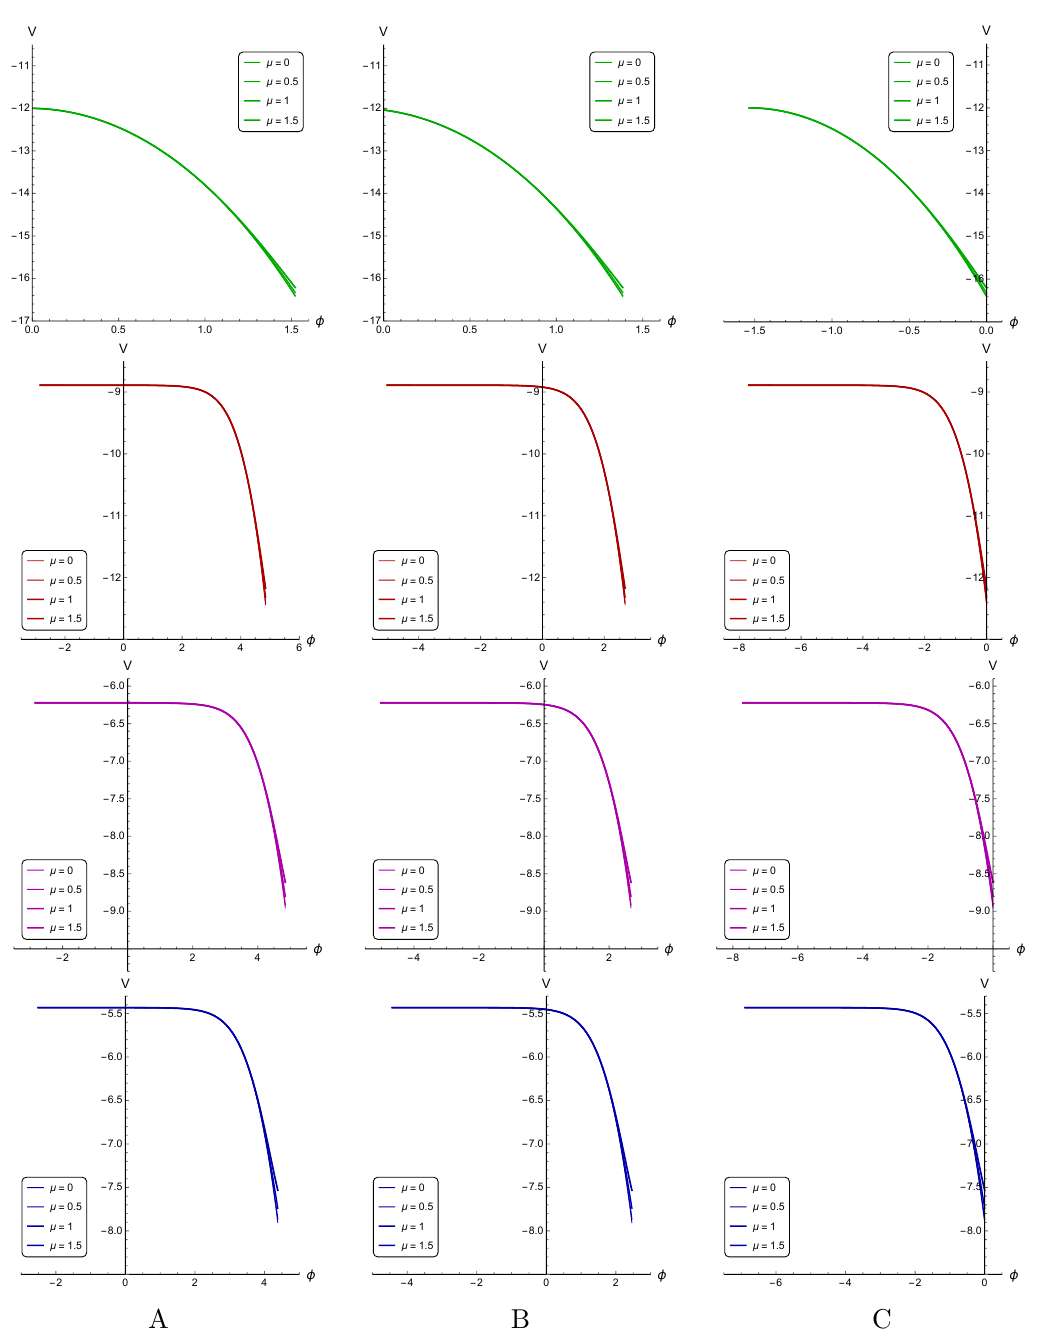
Figure 10 . Scalar field potential V ( φ ) for different µ in isotropic (1-st line) and anisotropic cases for ν = 1 . 5 (2-nd line), ν = 3 (3-rd line) and ν = 4 . 5 (4-th line) for boundary z 0 = 0 . 01 (A), z 0 = 0 . 1 (B) and z 0 = 1 (C); a = 4 . 046 , b = 0 . 01613 , c = 0 . 227 and z h = 1 . Vertical lines show the boundary of valid scalar field values ( φ ( z h )) ; for plots from the column C the axis V ( φ ) serves as such a boundary, because these are plots for φ ( z h ) = 0